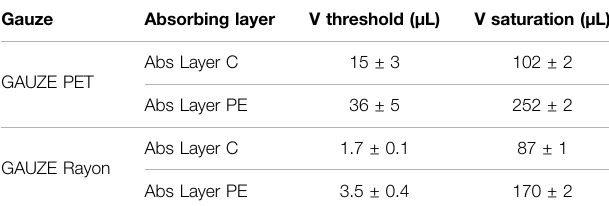
TABLE 3 | Moisture sensor parameters in different bandage architectures. The spacing between the two electrodes is fi xed to 2 mm.